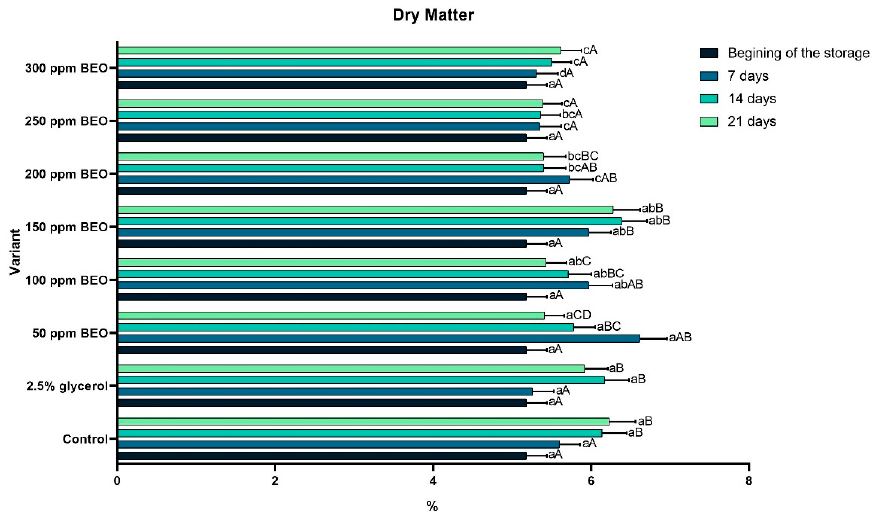
Figure 3. Effects of applied treatments on dry matter (%) during storage for 21 days at 8 ± 1 ◦ C. Bars for the same sampling time followed by different lowercase letters are significantly different based on the least significant difference (LSD) test ( p < 0.05). Bars for the same treatment during storage time followed by different uppercase letters are significantly different based on the least significant difference (LSD) test ( p <